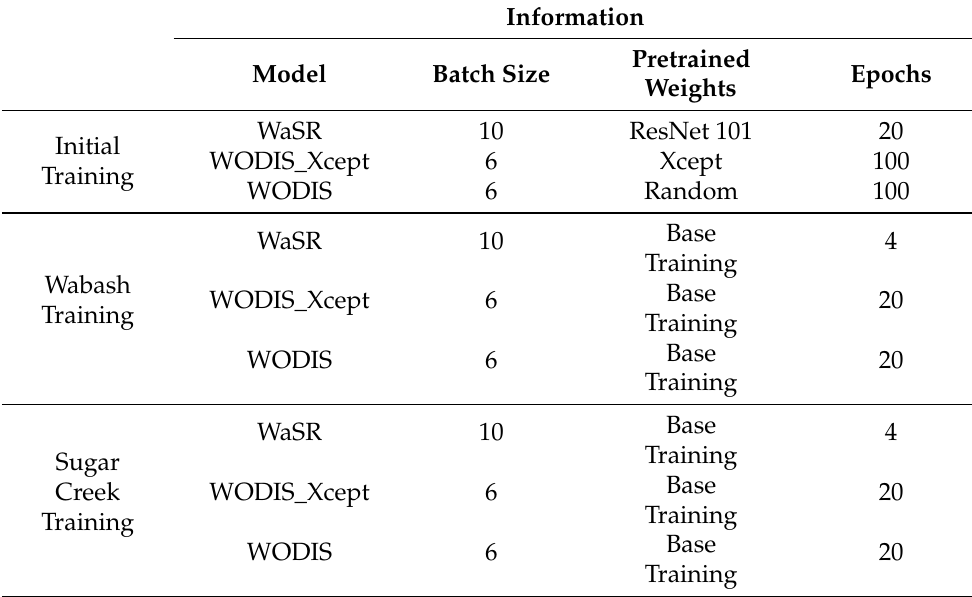
Table 2. Training parameters and weight initialization used for all the networks for each training session. Initial training is training the network on the augmented dataset as detailed in Section 4.3. The Wabash and Sugar Creek training each continue training for the epochs listed. During both instances, the networks are initialized with their respective weights from the initial